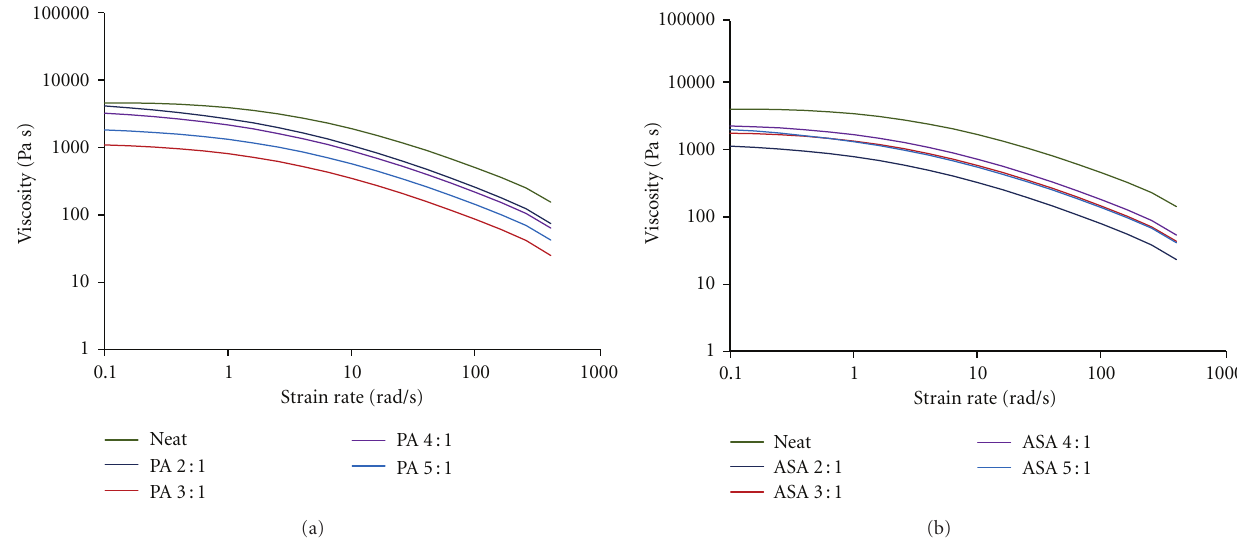
Figure 7: Complex viscosity as a function of frequency at 220 ◦ C for neat PMMA and PMMA nanocomposites of PA:Tb 3+ :LaF 3 (a) and ASA:Tb 3+ :LaF 3 (b) at varying ligand to nanoparticle